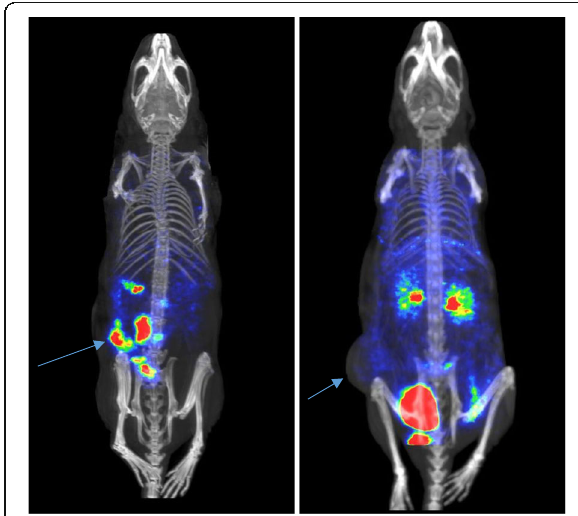
Fig. 7 Whole body PET images in representative nude mice with MDA-MB-231 tumor from three groups tested. Coronal PET images obtained after 60-min post-injection of 68 Ga-DOTA-Ahx-BN peptide (~ 100 ng, ~ 100 μ Ci). (Left) Tumor is clearly visible in the image suggesting receptor-specific tumor uptake. (Right) Tumor is hardly detectable in PET image under blocking condition in the presence of 300 μ g cold BN peptide to block BN/GRP receptors. Arrows indicate the location of